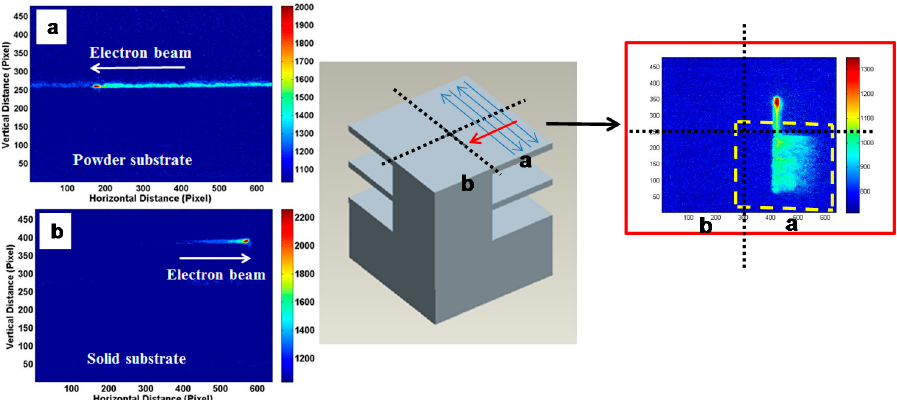
Figure 3. Thermal images from building overhang-type features, showing drastically different temperature distributions between scanning on a solid substrate and on an overhang. Left 2 images: temperature contour in scanning the powder and solid substrates ( a , b ); Middle image: illustration of the beam scanning pattern (blue arrow: scanning direction, red arrow: rastering direction); Right image: Temperature contour showing substantial heat retention on the overhang surface.